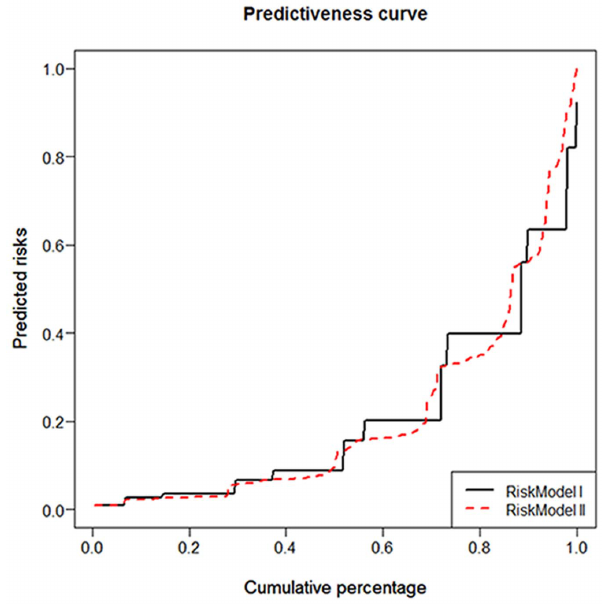
Figure 5. Predictiveness curves illustrating the prognostic performance of two different risk models in predicting cardiac events (CE). Risk model I: clinical TIMI risk score and gender; Risk model II: clinical TIMI risk score, gender, and hs-cTnT,